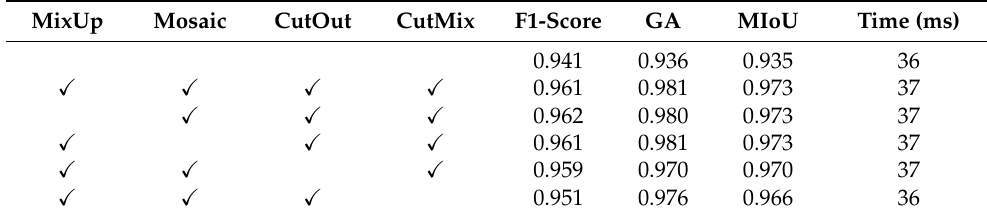
Table 4. Results of four enhancement methods. MixUp